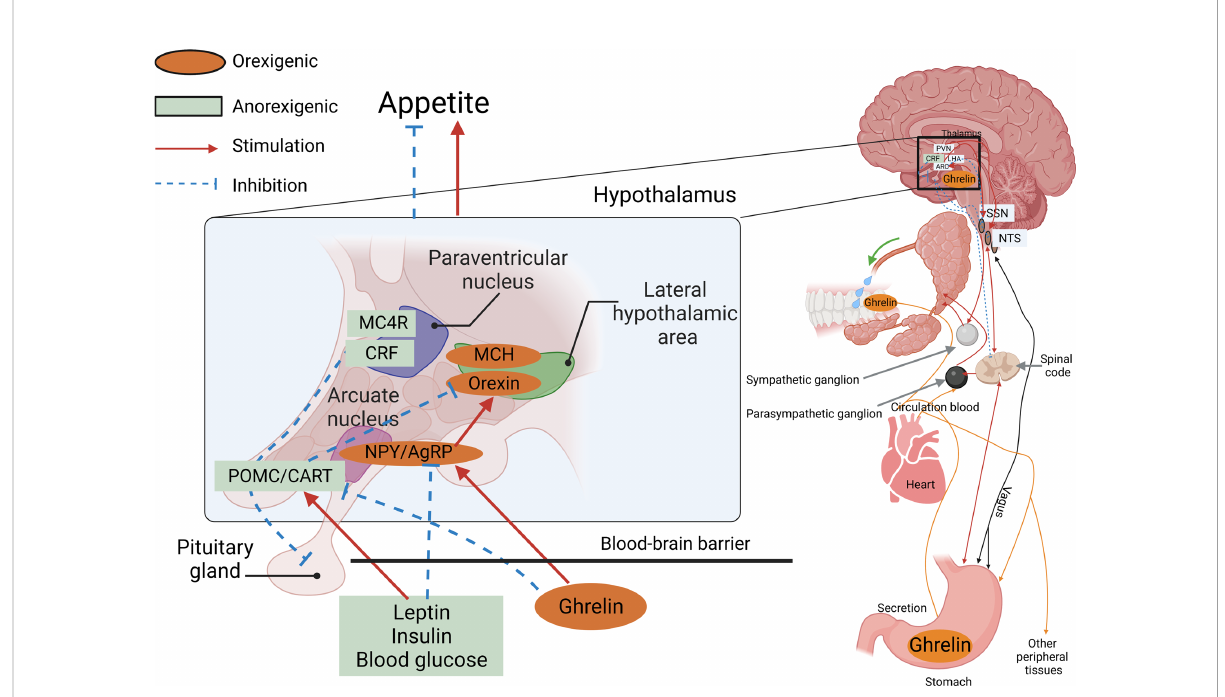
FIGURE 1 AGRP neuropeptide is released by AgRP neurons. An AgRP neuron ’ s location within the arcuate nucleus of the hypothalamus, co-positioned with POMC neurons located in the median eminence, and an incomplete blood – brain barrier (BBB) receive information from the peripheral